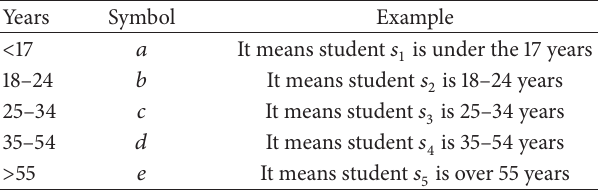
Table 1: Learners’ age segment table.